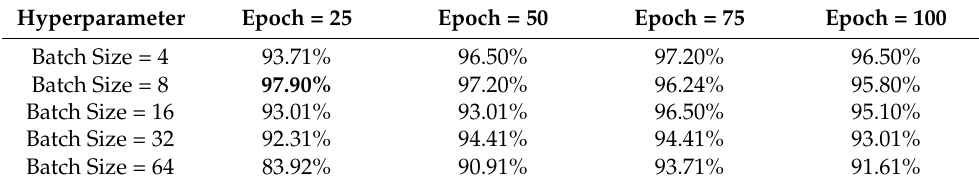
Table 2. Experimental test results of KRS-Net.